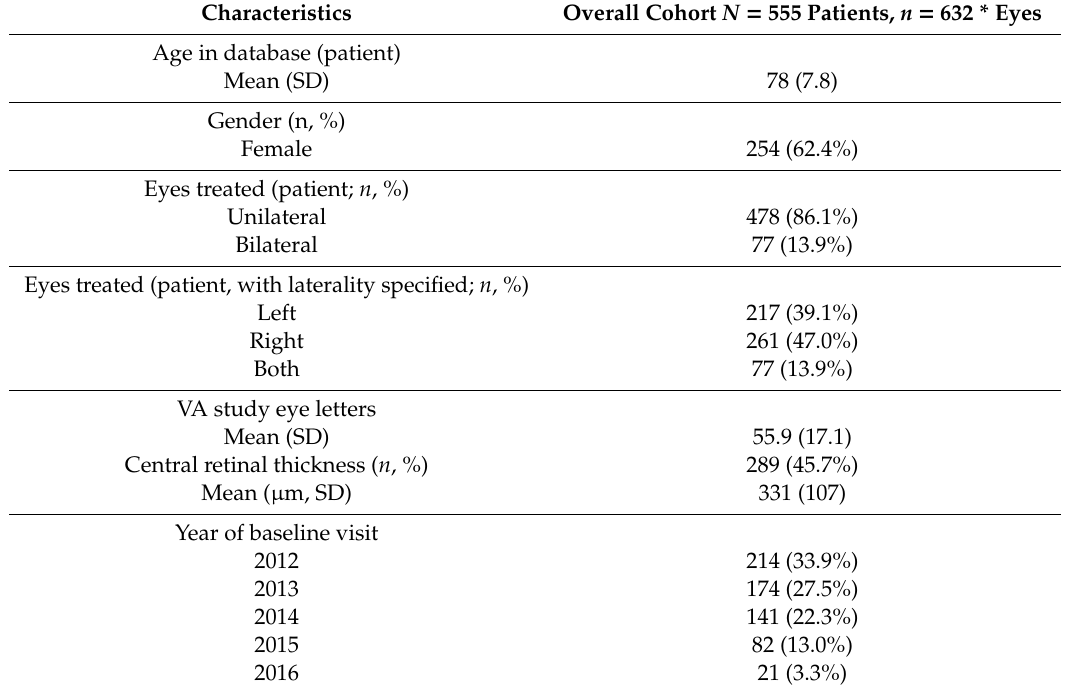
Table 2. Baseline patient characteristics—overall